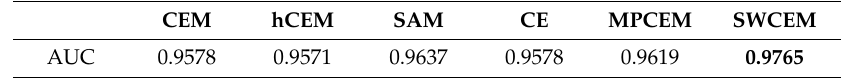
Table 4. The area surrounded by ROC curves of different algorithms on the AVIRIS Dataset 1.